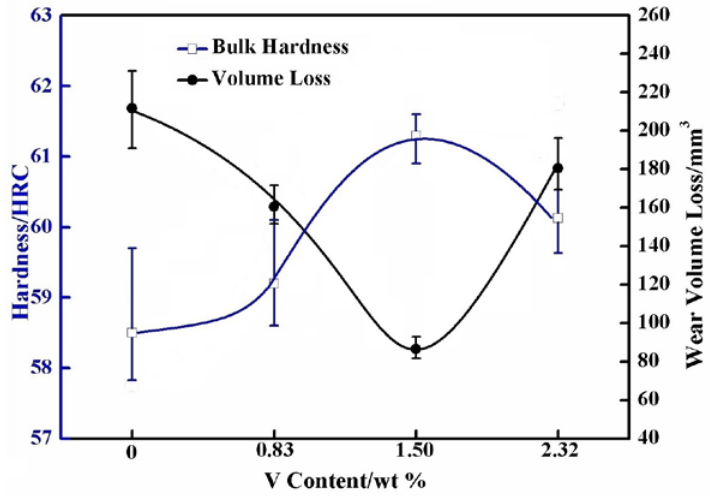
Figure 14. Changes in the hardness and wear volume loss of HCCI hardfacing layer.